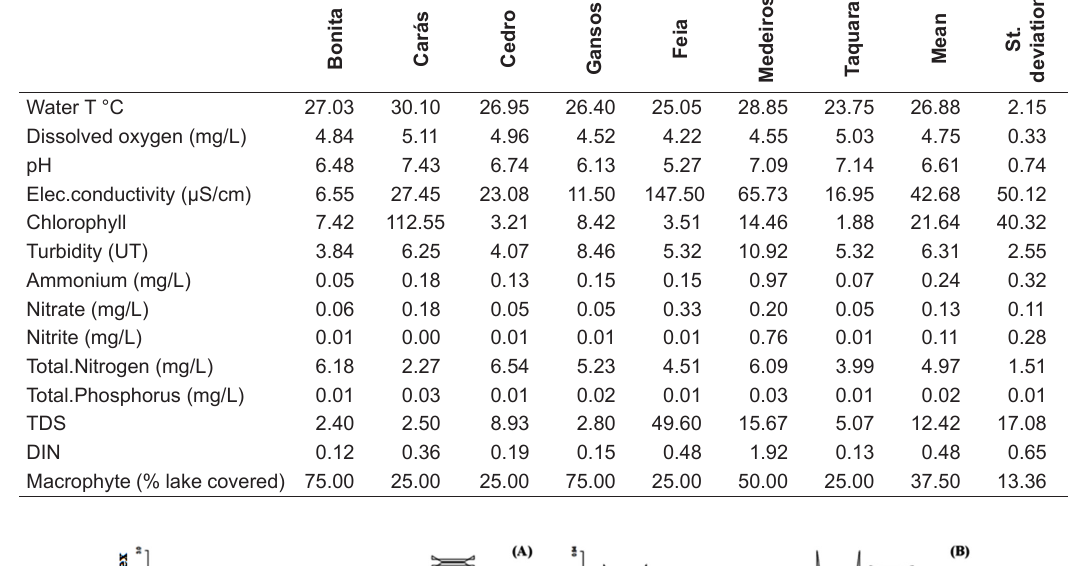
Table 1. Mean and standard deviation values of the environmental variables in seven tropical shallow lake of Brazilian savannah.